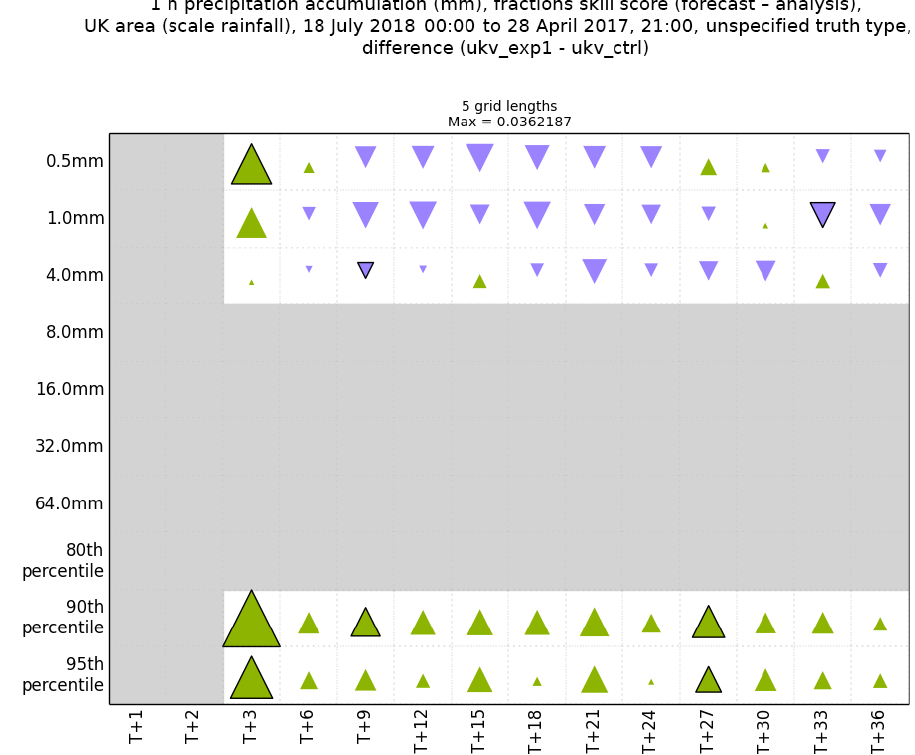
Figure 10. FSS at five grid lengths for 1h accumulations.